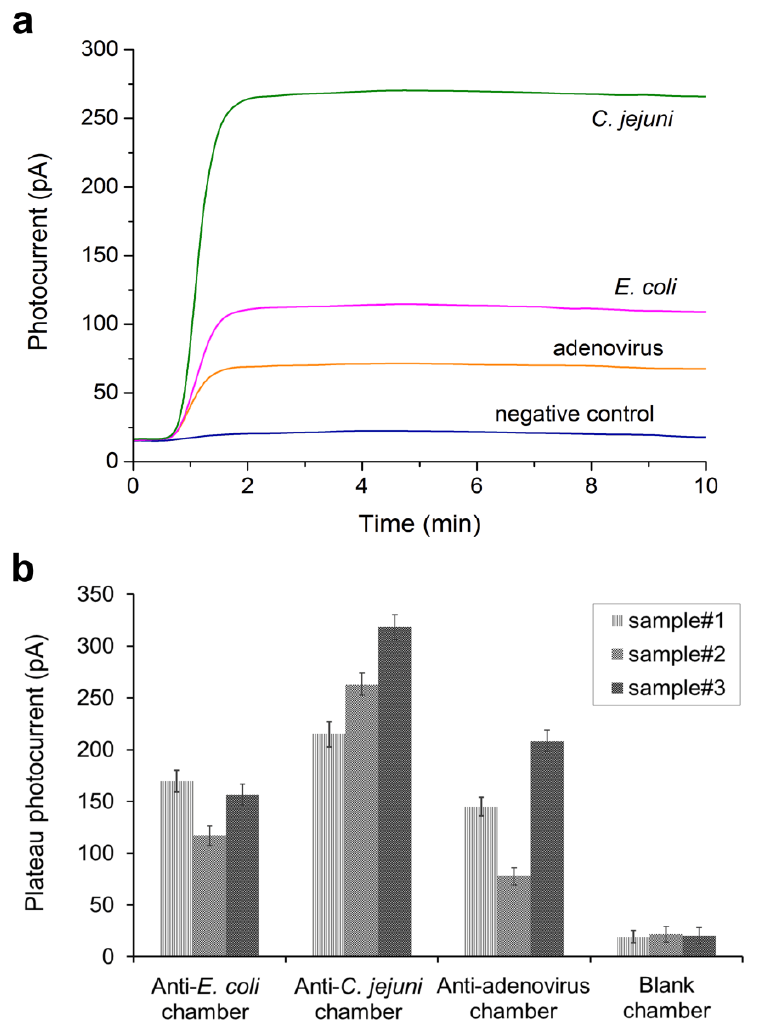
O157:H7, C. jejuni and adenovirus at one spiked sample. ( b ) Multiplexed detection tests using three mixture samples of the three pathogens (labelled as sample#1, sample#2 and sample#3). Sample#1 contained 6.5 × 10 6 cells/mL E. coli , 3 × 10 7 cells/mL C. jejuni and 5 × 10 −7 mg/mL adenovirus. Sample#2 was made of 5×10 6 cells/mL E. coli , 5 × 10 7 cells/mL C. jejuni and 1 × 10 −7 mg/mL adenovirus. Sample#3 contained 6.5 × 10 6 cells/mL E. coli